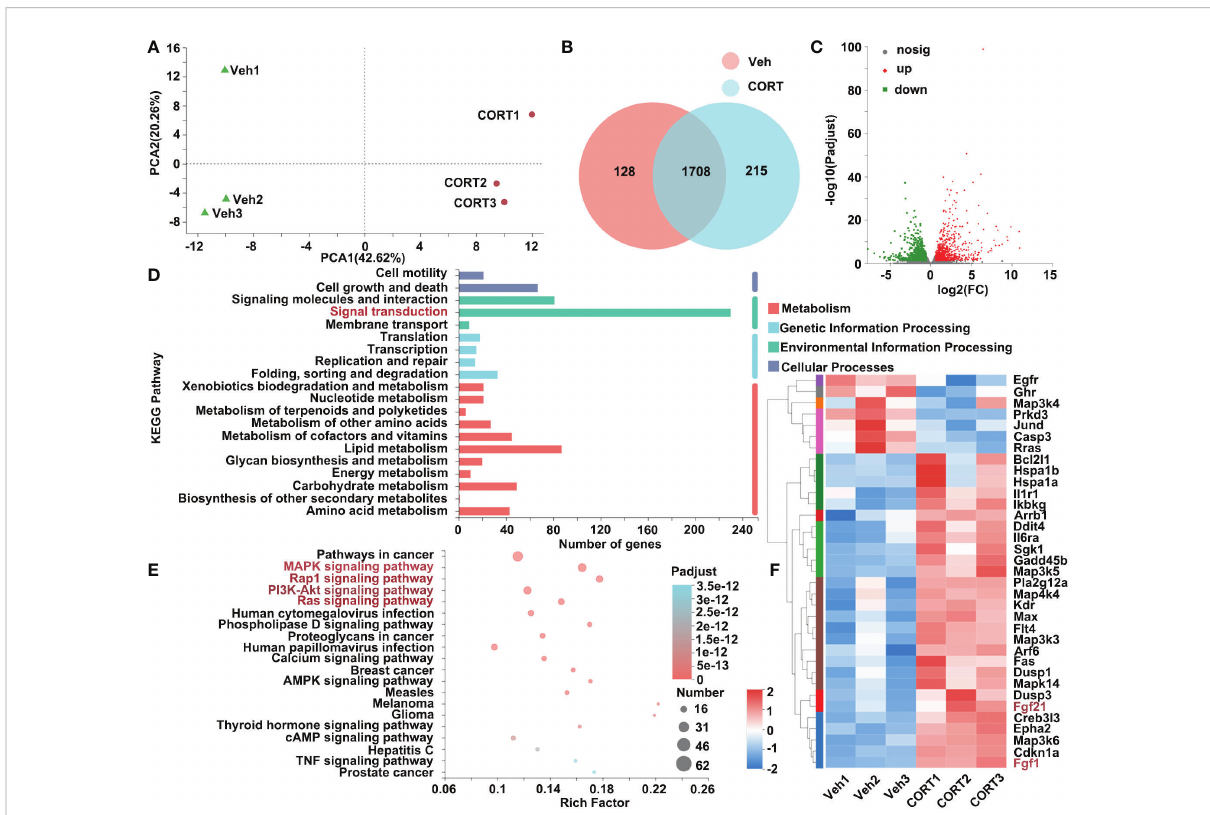
FIGURE 4 Identi fi cation of genes that were differentially expressed in livers in response to CORT treatment. (A) Principal component analysis of the transcriptome of the liver samples collected from the mice administrated with CORT or Vehicle. (B) Venn diagram displaying the distribution of DEGs (genes with > 1.5-fold change in expression) for the liver samples of the two groups. If the TPM value of the gene was lower than 1, the gene was considered to be not expressed in the livers of the group. (C) Volcano plots of the DEGs for the liver samples of the two groups. The up-regulated genes are presented by red dots, and the down-regulated genes are presented by green dots. (D) The functional classi fi cation of DEGs for livers of the 2 groups based on fi rst-category KEGG pathway analysis. (E) The functional classi fi cation of DEGs for livers of the 2 groups based on second-category KEGG pathway analysis. (F) Heatmap of DEGs commonly expressed in the 4 pathways (labeled in red, 4E) for livers of the 2 groups in the category of “ signal transduction ” . Veh: vehicle-treated group; CORT: corticosterone-treated